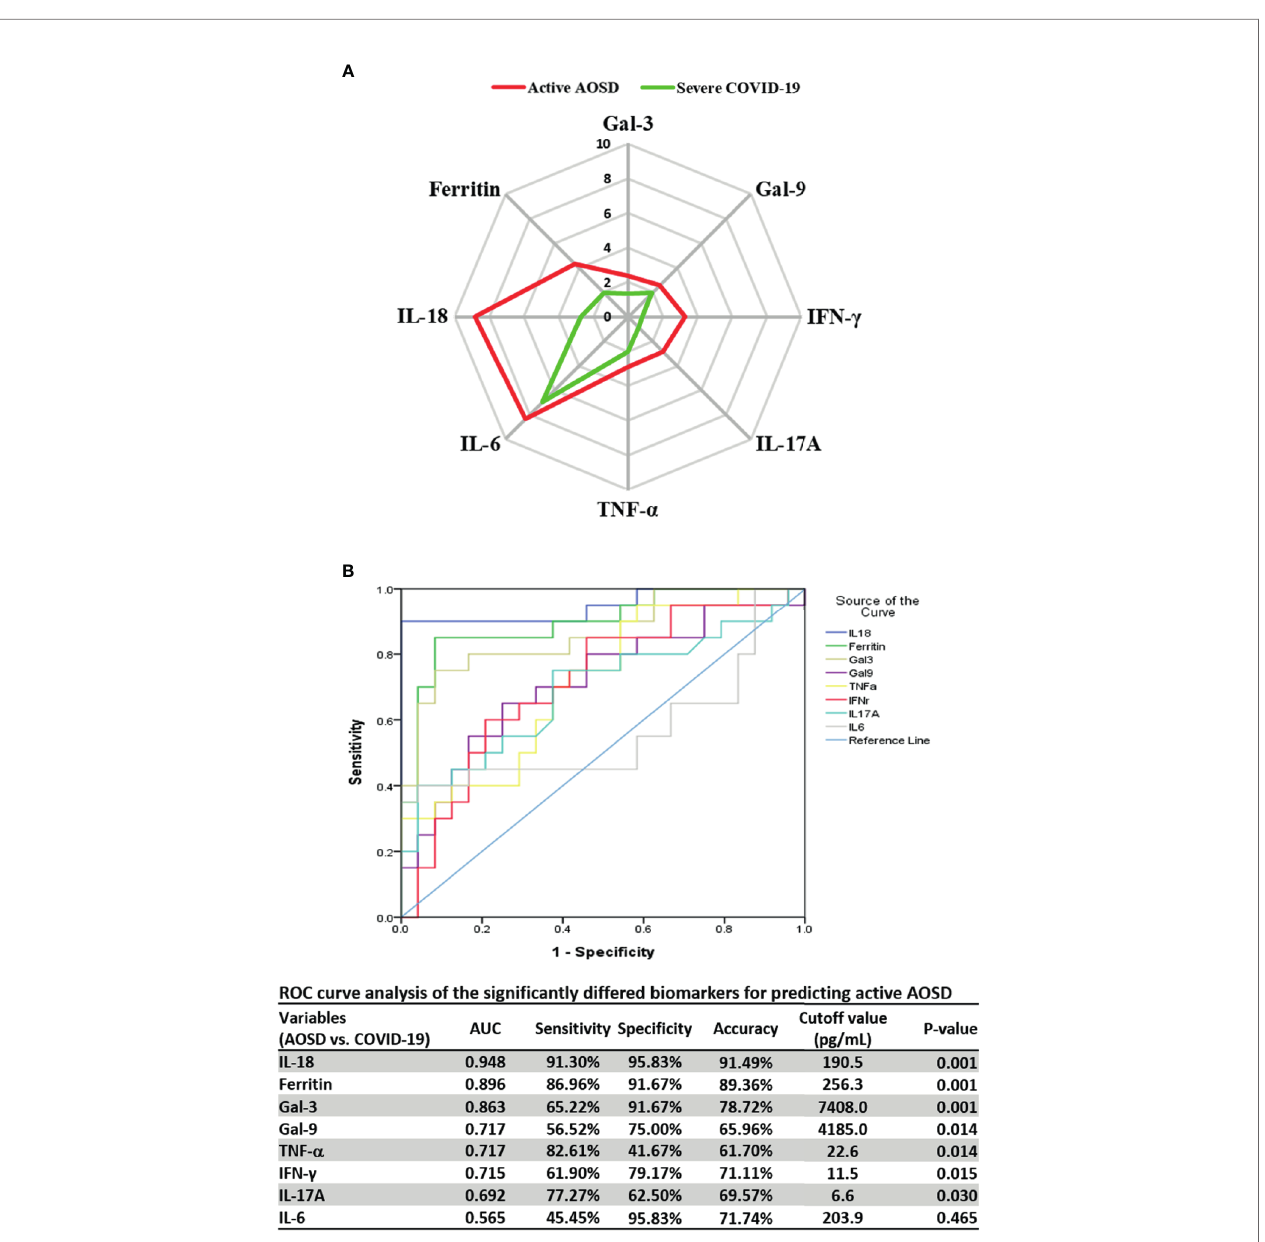
FIGURE 3 | Signi fi cantly different galectins and cytokines between active AOSD and severe COVID-19, and ROC curves analysis. (A) The signi fi cantly different levels of galectins and cytokine pro fi les shown by radar charts between active AOSD and severe COVID-19. (B) The ROC curves analysis of the signi fi cantly differed biomarkers for predicting active AOSD. The illustrated levels in (A) were presented as Log2 fold changes of markers, de fi ned as the median expression level ratio of active AOSD or severe COVID-19 to healthy subjects. AOSD, adult-onset Still ’ s disease; COVID-19, coronavirus disease 2019; ROC, receiver-operating characteristic; AUC, area under ROC